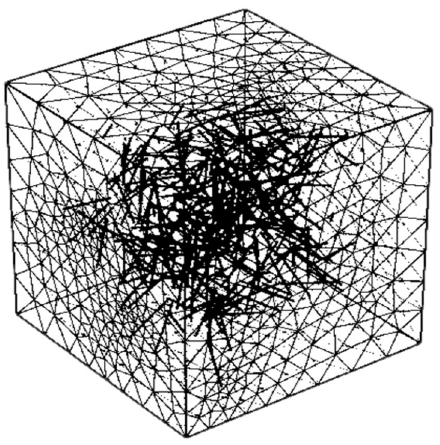
Figure 2. The mesh of a sample finite element model, after [46].